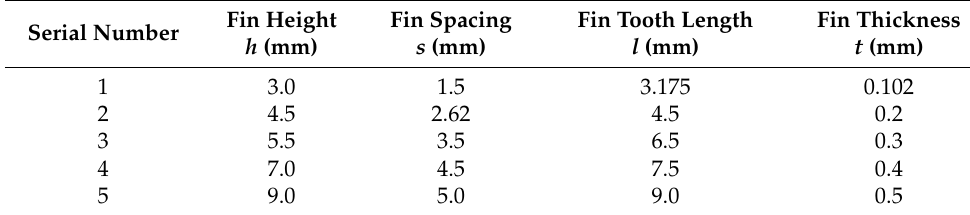
Table 5. Fin structure parameters of calculation